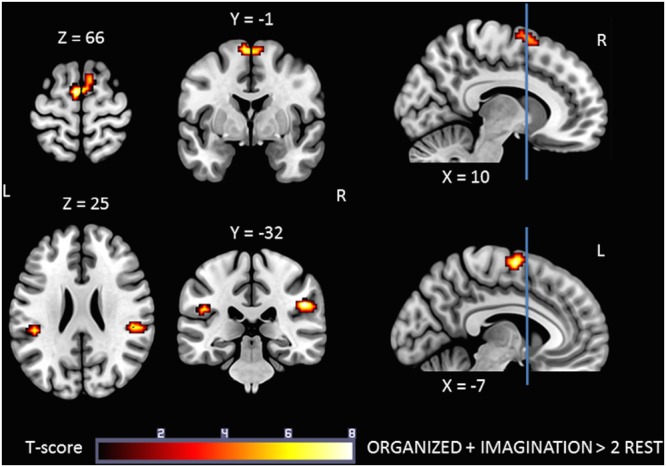
Statistical parametric map for the ORGANIZED + IMAGINATION > RESTOrganized + RESTImagination contrast representing common activations between gait-like plantar stimulation and mental imagery of walking; p-value threshold of <0.05 FDR-corrected at voxel level with a minimum cluster extent of ten contiguous voxels; images are presented according to neurological convention (R = right, L = left). Blue lines in the sagittal images represent the vertical plane passing through the anterior commissure separating pre-SMA (anteriorly) and SMA proper (posteriorly). See text for details.